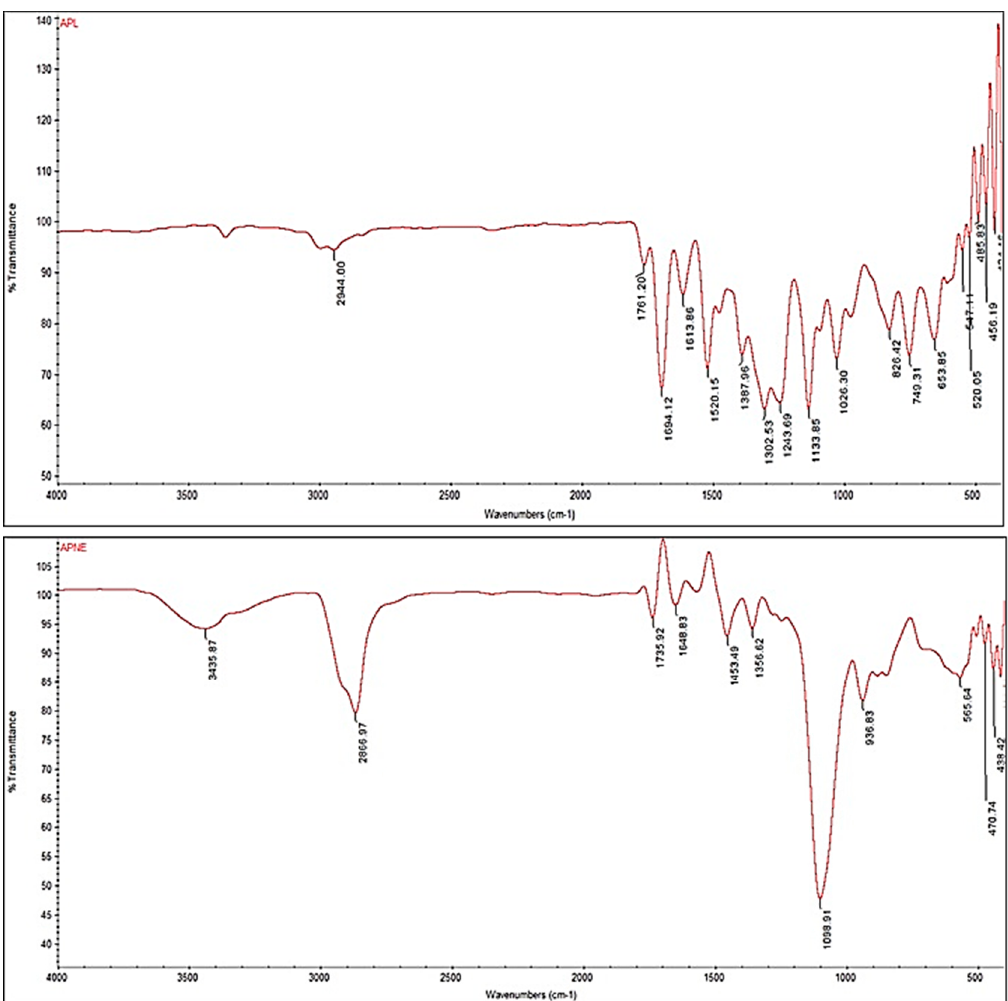
Figure 5. FTIR spectrums of pure APL and APL ‐ loaded NEs (ANE4).